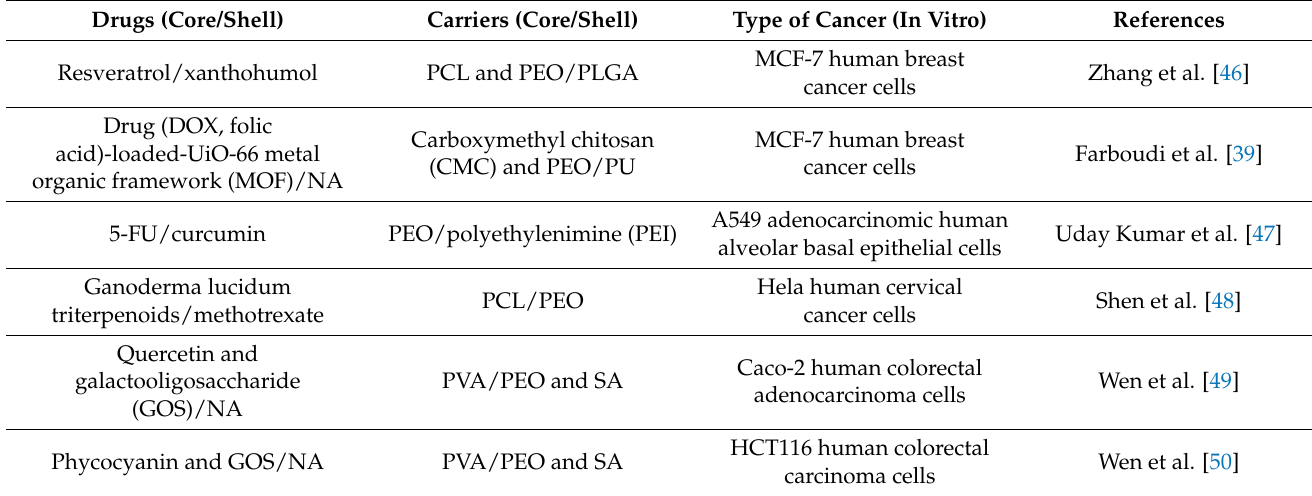
Table 2. Multidrug-loaded coaxial electrospun